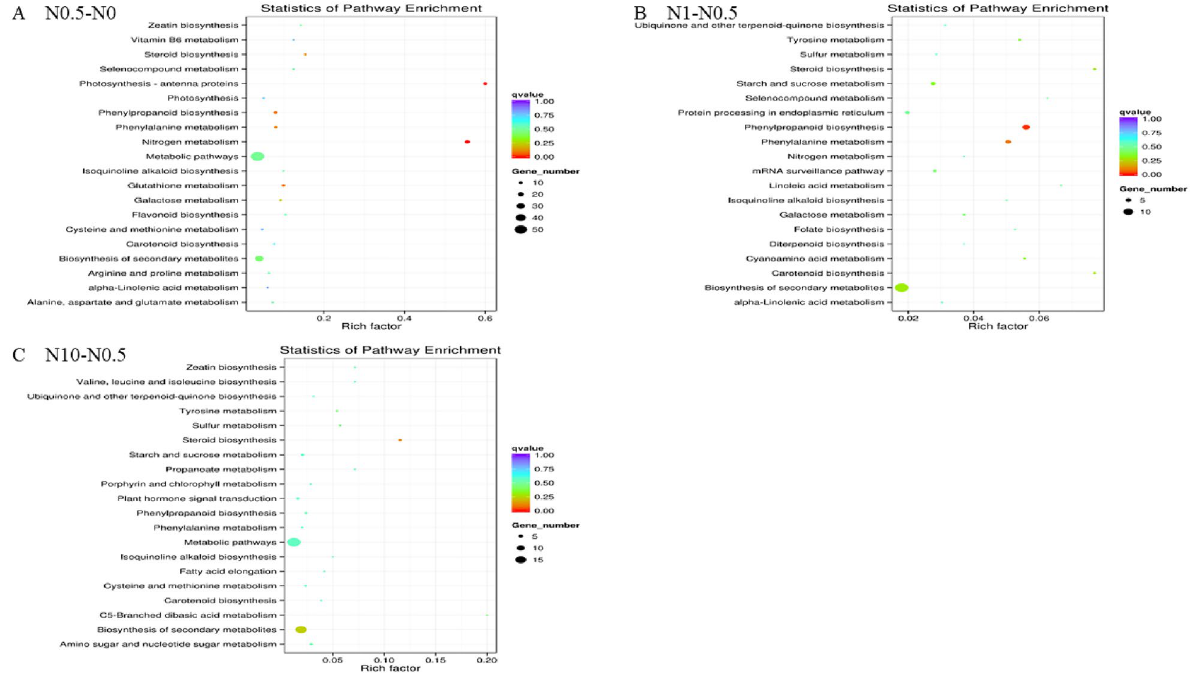
Figure 7. KEGG enrichment distribution of DEGs. ( A ) shows the enrichment of DEGs in the pathway in the N0.5 treatment versus N0. ( B , C ) show the N1 treatment versus N0.5, and the N10 treatment versus N0.5, respectively. The vertical axis represents the pathway name, the horizontal axis represents the rich factor, the size of the dots represents the number of DEGs in the pathway, and the colour of the dots corresponds to different q-value ranges.